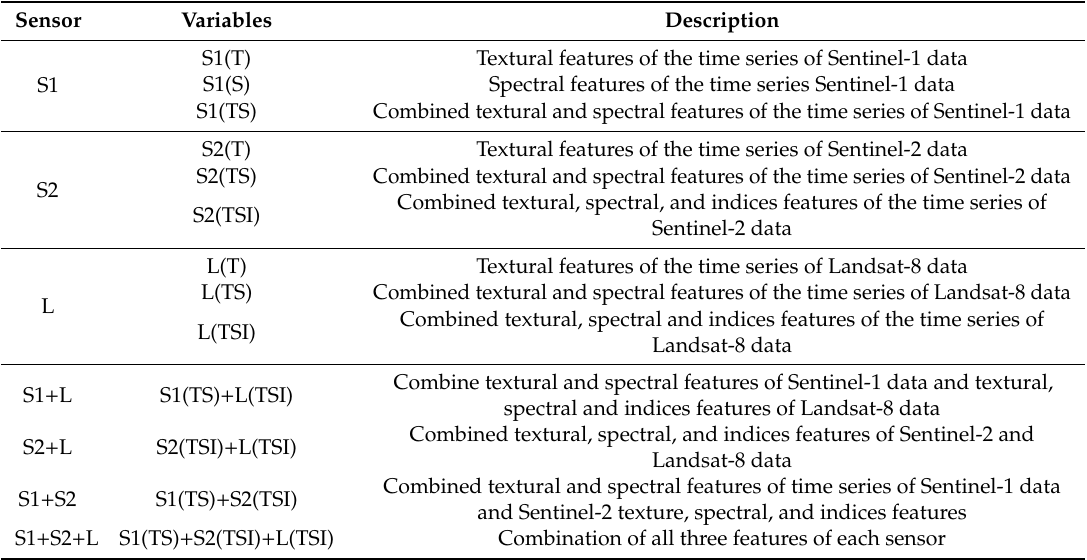
Table 5. Description of the combined vector variables. The S1 represents Sentinel-1, S2 represents Sentinel-2, L represents Landsat-08; T represents Texture feature, S represents Spectral feature, I represents Index feature; TS: Texture + Spectral; TSI: Texture + Spectral +